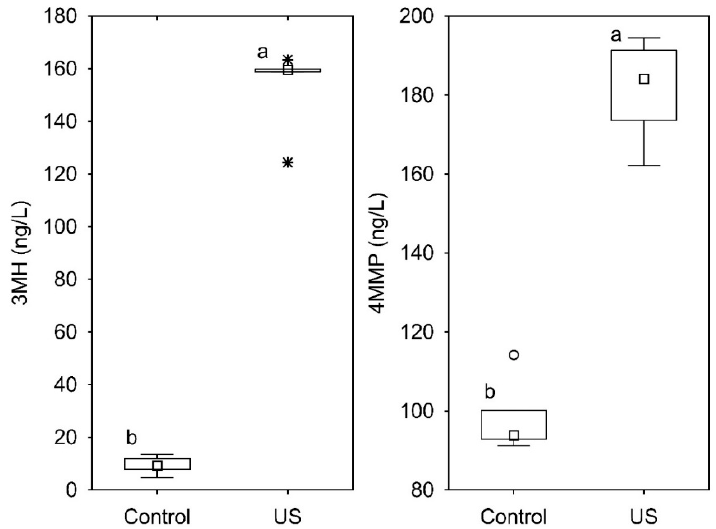
Figure 4. Concentration distribution of 3-mercaptohexan-1-ol (3MH) and 4-mercapto-4-methyl pentan-2-one (4MMP) in the model solution in control and treated (US) samples after 5 min of sonication. Different letters indicate mean values statistically differentiated. * Outliers